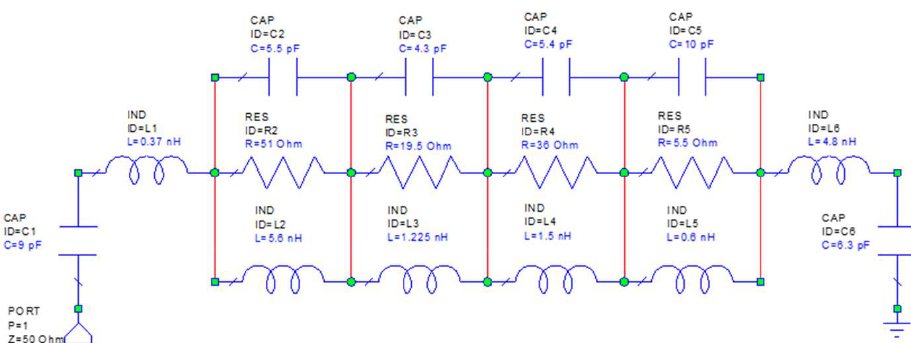
Figure 8. Equivalent circuit of the wideband biconical printed antenna.